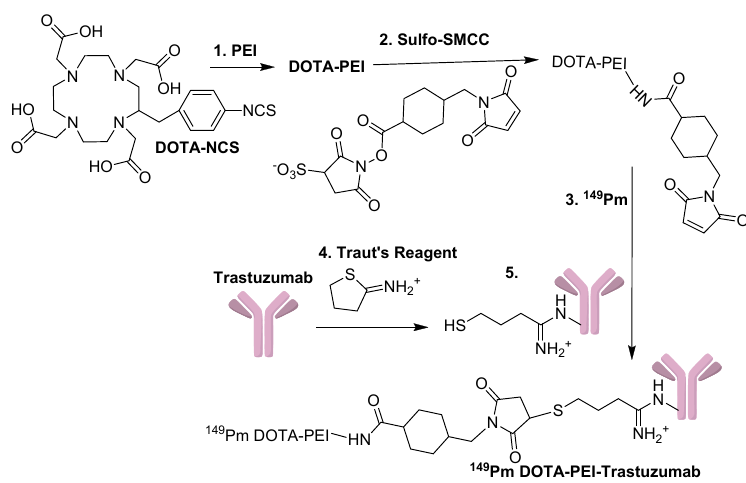
Figure 2. Synthetic scheme used to make 149 Pm-DOTA-PEI-Trastuzumab. Reaction conditions: (1) NaHCO 3 pH = 8.5, (2) PBS, RT, 1 h, (3) NH 4 Ac pH = 6.0, 80 ˝ C, 1 h, (4) NaHCO 3 pH = 8.5, EDTA, RT, 1 h, and (5) PBS, 3 h,